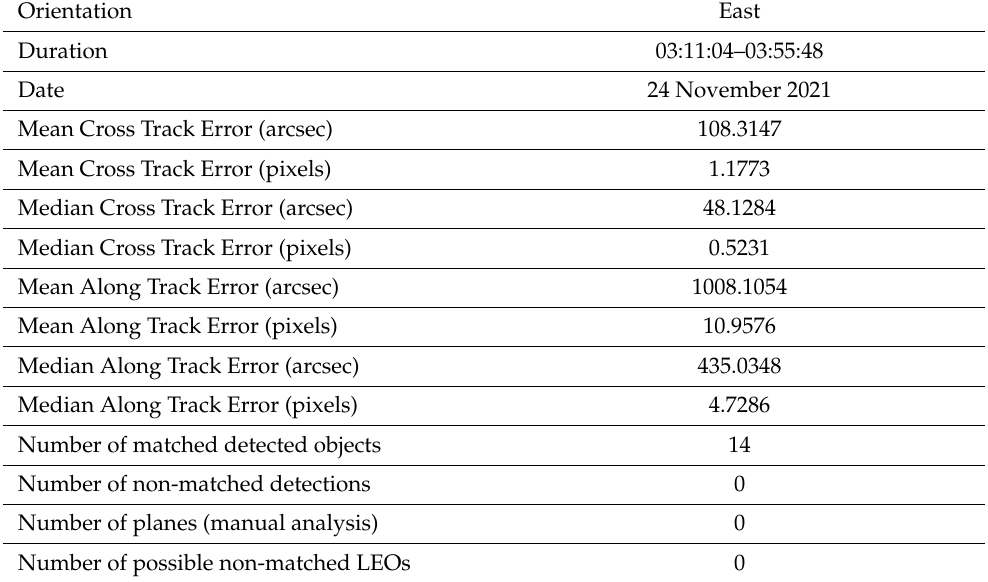
Table 2. Error statistics for the East